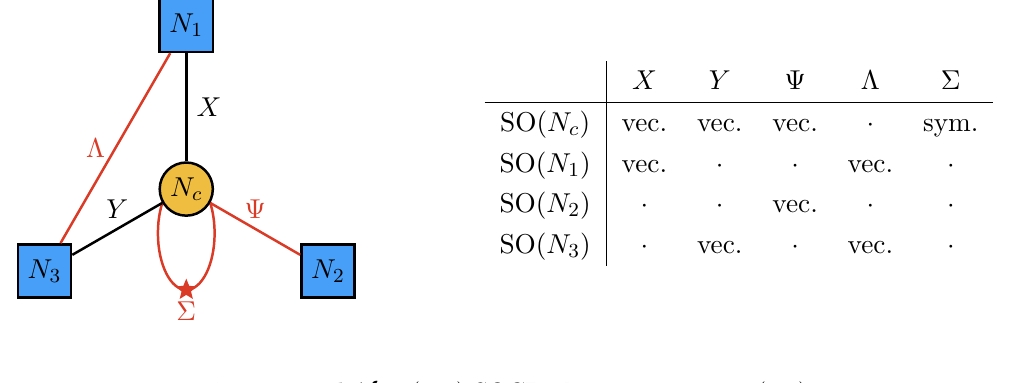
Figure 3 . 2 d N = (0 , 1) SQCD. N c is given in eq.